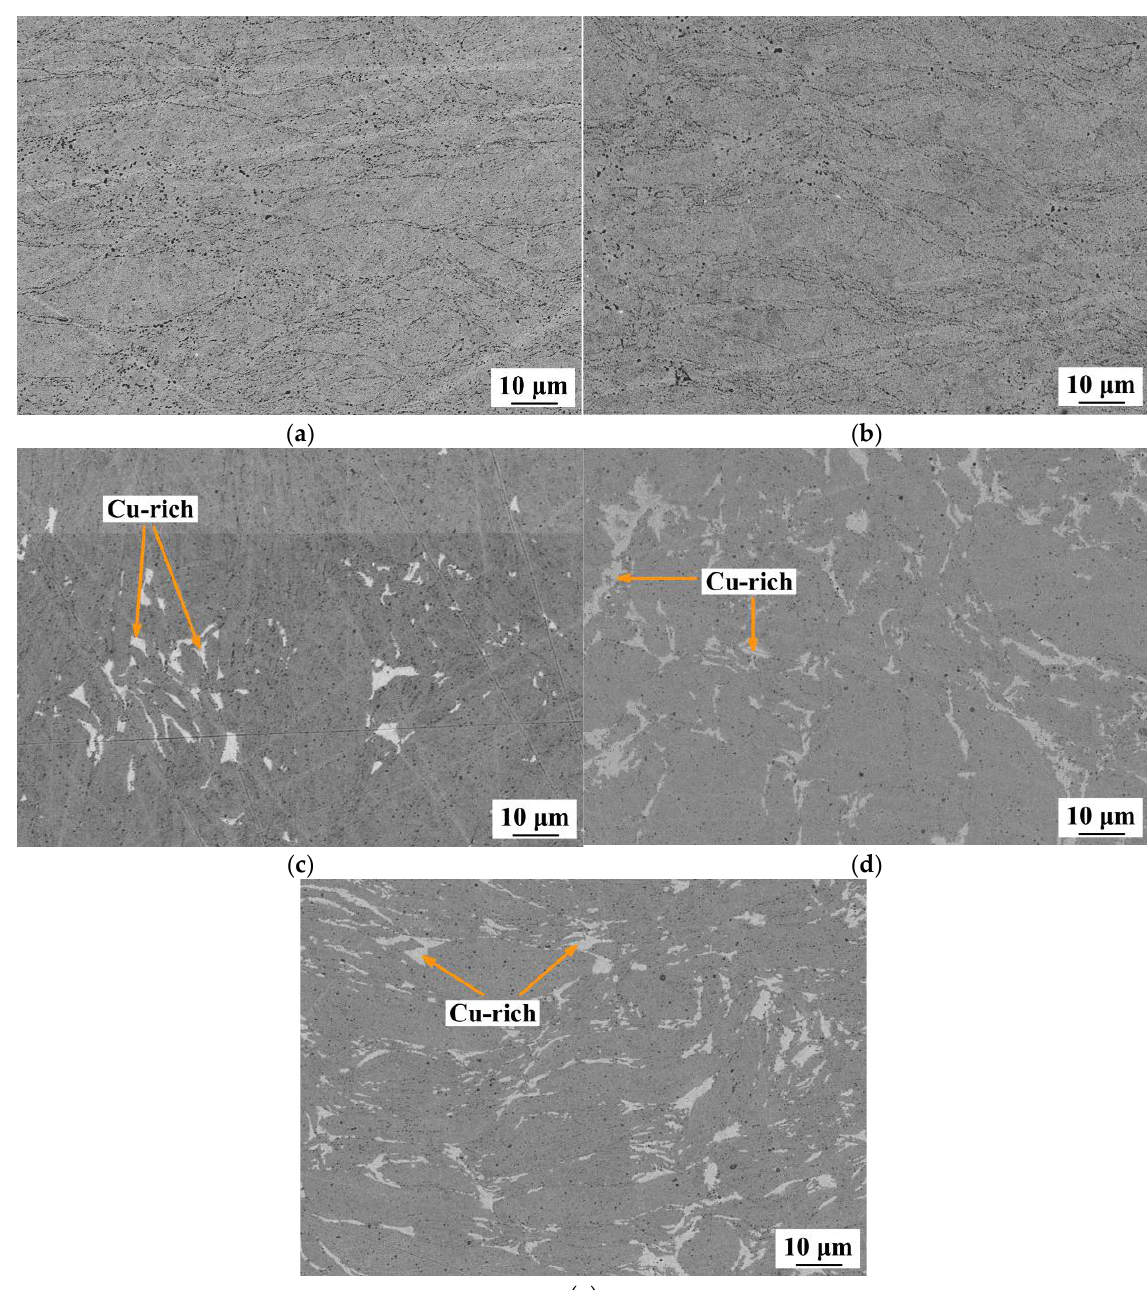
Figure 3. SEM images of the microstructure of the hot-pressed samples: ( a ) CoCrFeNi; ( b ) CoCrCu 0.25 FeNi; ( c ) CoCrCu 0.5 FeNi; ( d ) CoCrCu 0.75 FeNi; and ( e ) CoCrCuFeNi.